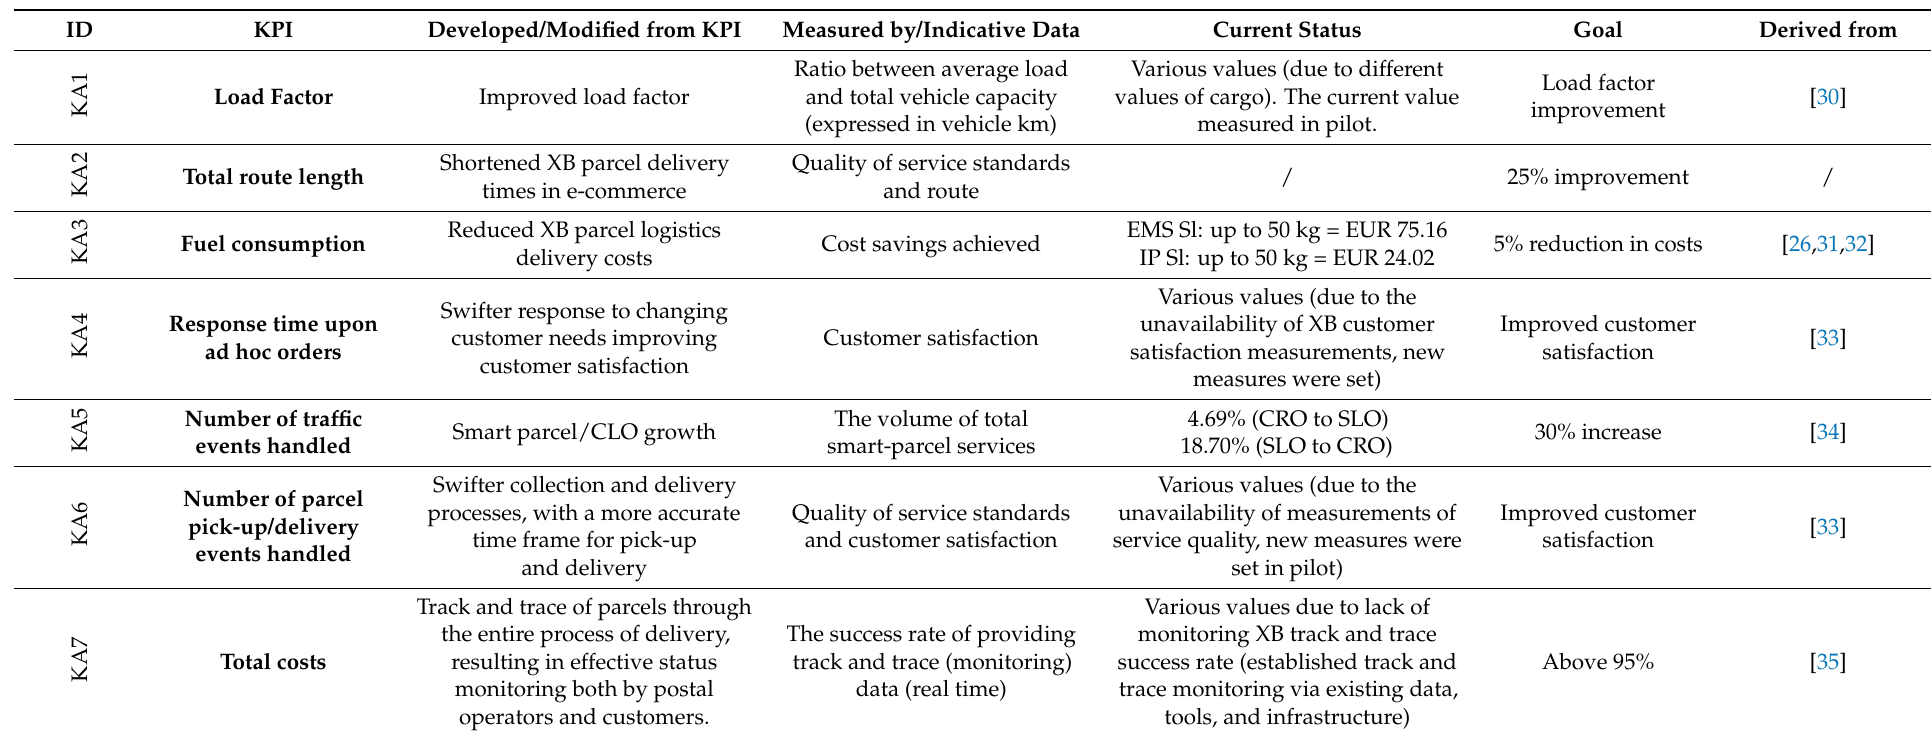
Table 2. Studied specifics of developed/modified